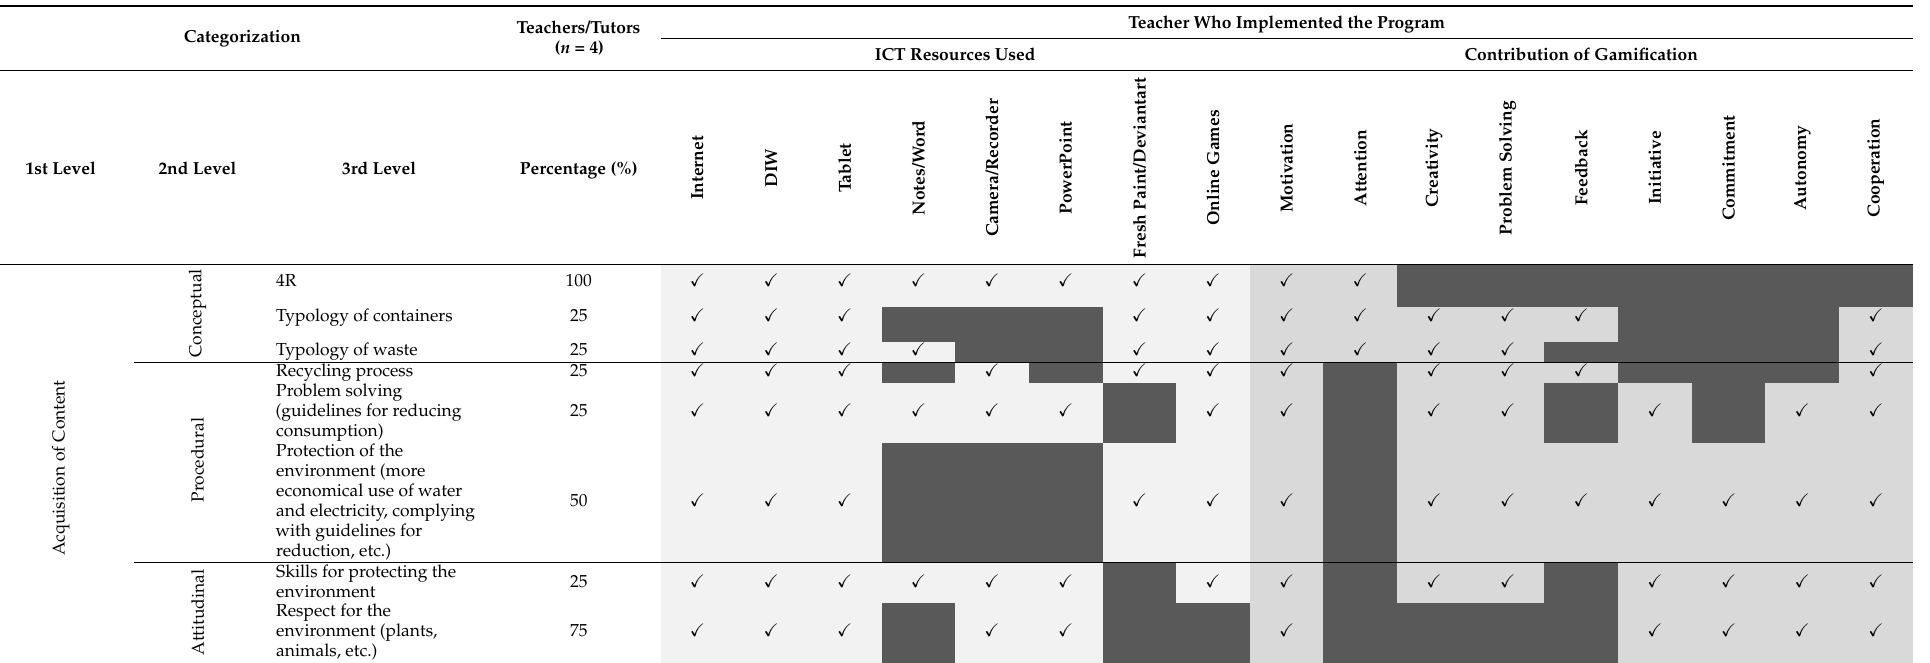
Table 3. Students’ assimilation of the academic content.